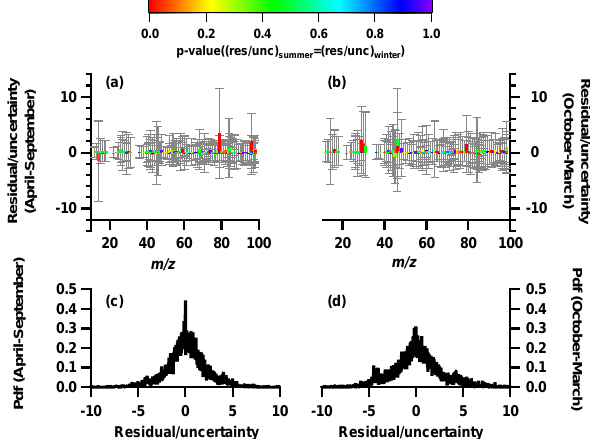
Figure 7. Residuals weighted with the uncertainty (residu- als/uncertainty) of the offline solutions for the periods April– September and October–March (example shown for one chosen so- lution, a HOA = 0 . 0; a COA = 0 . 0). Panels (a, b) show residuals as a function of m/z averaged over the whole periods color-coded with the probability that the residuals for April–September are the same as for October–March (Wilcoxon–Mann–Whitney test). Pan- els (c, d) shown the probability distribution function (pdf) of R/U during the same